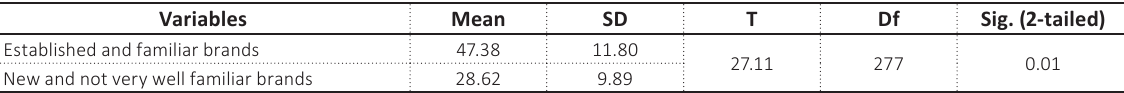
Table 7. Attitudes toward familiar and established brands compared to unfamiliar and new brands in Web Series brand placement